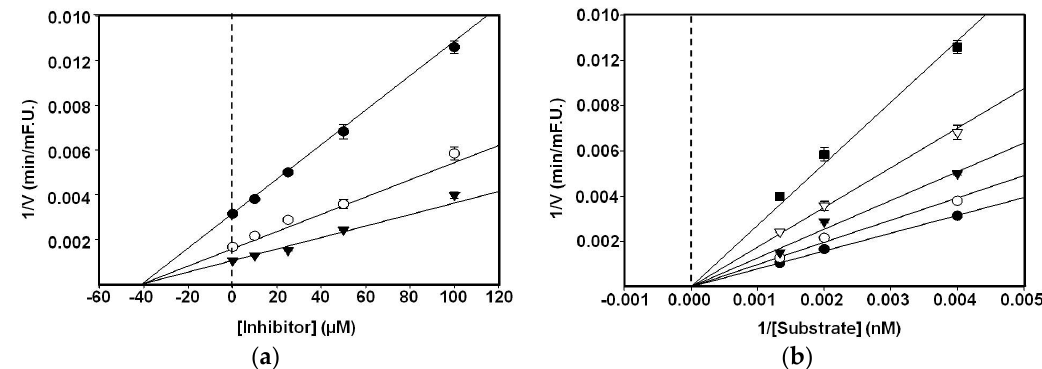
Figure 2. Dixon plot for BACE1 inhibition by biochanin A ( a ). Biochanin A was in the presence of different concentration of substrate: 250 nM ( ● ); 500 nM ( ○ ); 750 nM ( ▼ ); Lineweaver–Burk plots for BACE1 inhibition of biochanin A ( b ). BACE1 inhibition was analyzed in the presence of different concentrations of biochanin A as follows: 0 μ M ( ● ); 12.5 μ M ( ○ ); 25 μ M ( ▼ ); 50 μ M ( ▽ ); 100 μ M ( ).